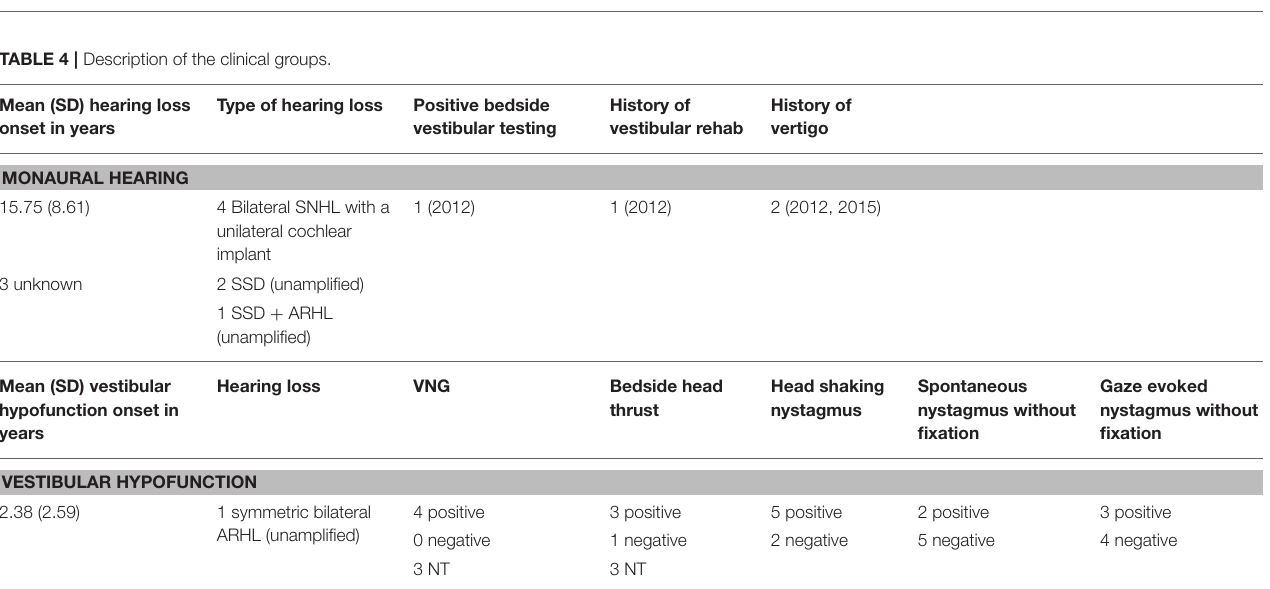
TABLE 4 | Description of the clinical